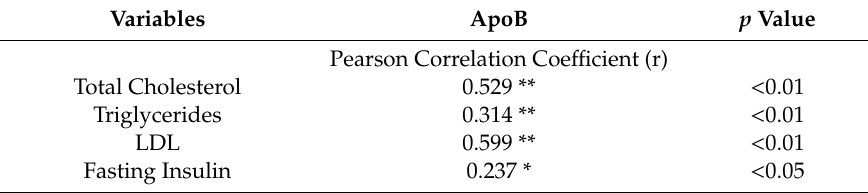
Table 7. Correlation between apolipoprotein-B and other study variables after 24 weeks of diet